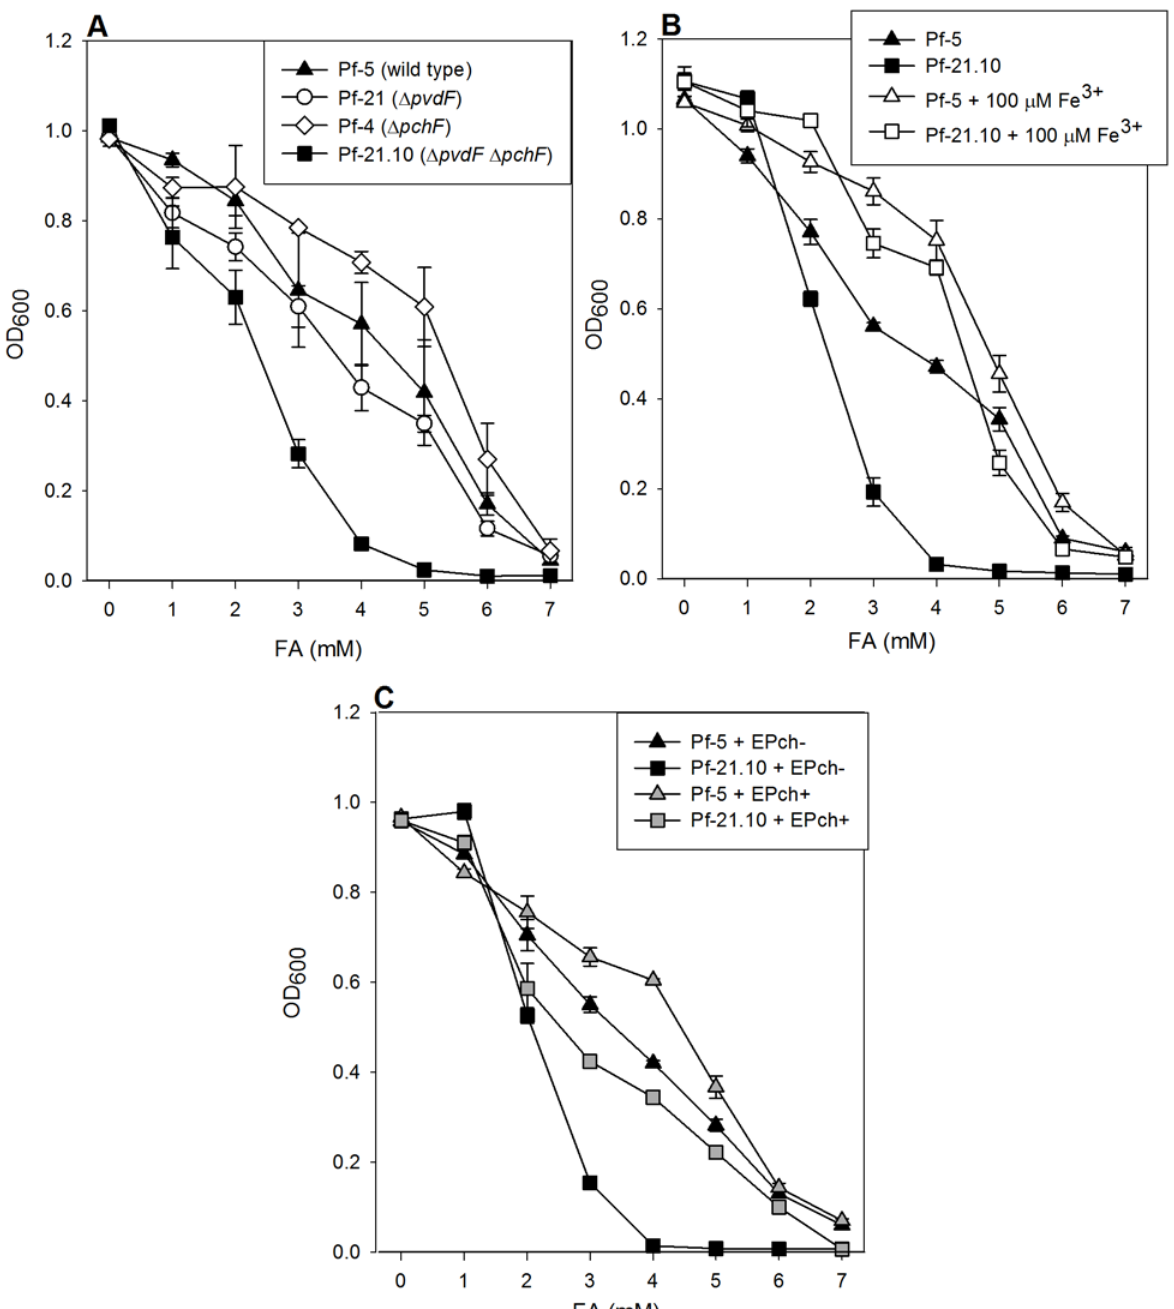
Figure 4. Correlation between siderophore production in P. protegens and resistance to FA. P. protegens Pf-5, P. protegens Pf-21, P. protegens Pf-4 and P. protegens Pf-21.10 were cultured aerobically during 16 h in 96-well polystyrene plates containing E 2 glucose minimal medium supplemented with increasing concentrations of FA ( A ). Cultures of P. protegens Pf-5 (wild type) and P. protegens Pf-21.10 ( Δ pvdF , Δ pchF ) were grown under the same conditions with or without FeCl 3 supplementation at a final concentration of 100 μ M ( B ). Cultures of P. protegens Pf-5 (wild type) and P. protegens Pf-21.10 ( Δ pvdF , Δ pchF ) were grown under the same conditions with or without EPch supplementation at a final concentration of 1.3 μ M ( C ). Values of maximal cell densities (OD 600 ) are shown. The experiments were performed three times and error bars represent the standard deviation of the mean.